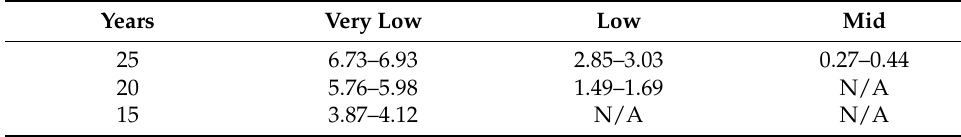
Table 18. Fixed Range of Balance Model.